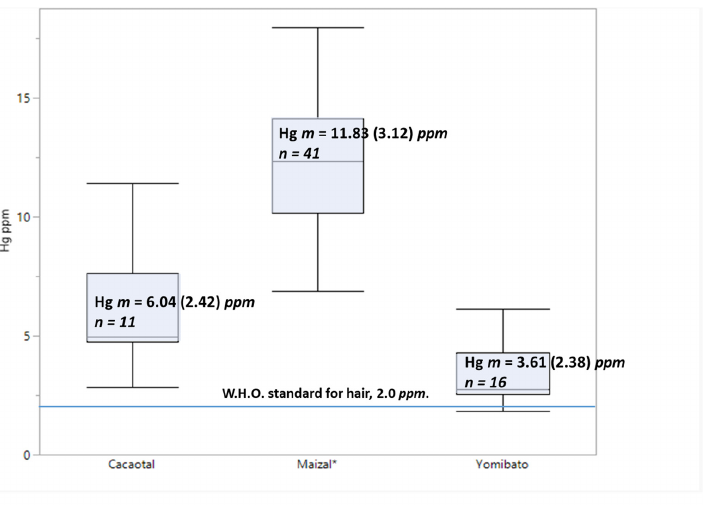
Figure 3. Hg levels per village with both the 2017 and 2018 cohort for the village of Maizal. Boxes show mean, interquartile range, and 2.5-97.5 percentiles.